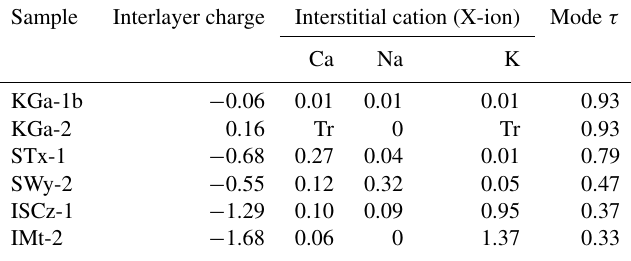
Table 8. Measured values of τ compared to the interlayer charge and cation ratios from structural formulae derived from elemental analysis (Tr is trace). Reference material is from the Clay Minerals Society.